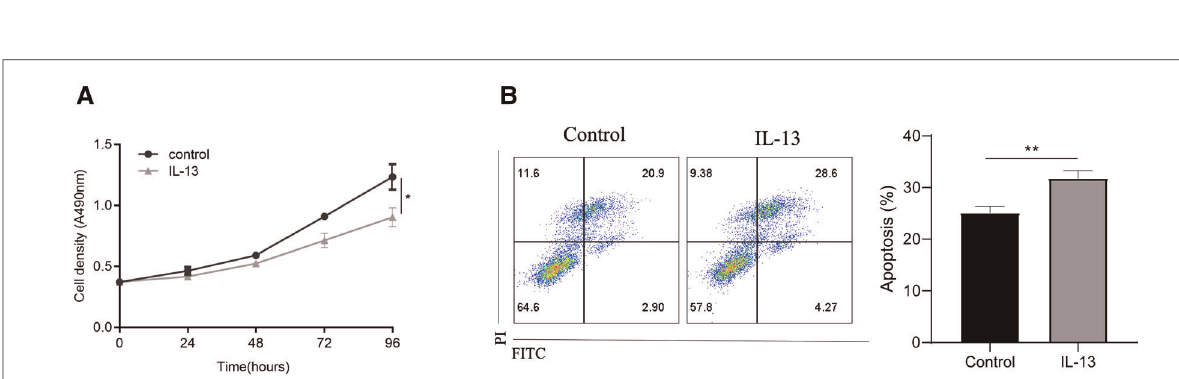
FIGURE 5 IL-13 stimulation enhances CLCA1 expression and downregulates bronchial epithelial cell function in vitro . BEAS-2B cells were stimulated with IL-13. Following stimulation, ( A ) cell proliferation was assessed using the CCK-8 assay and ( B ) apoptotic cells were assessed via fl ow cytometry. * p <0.05, ** p